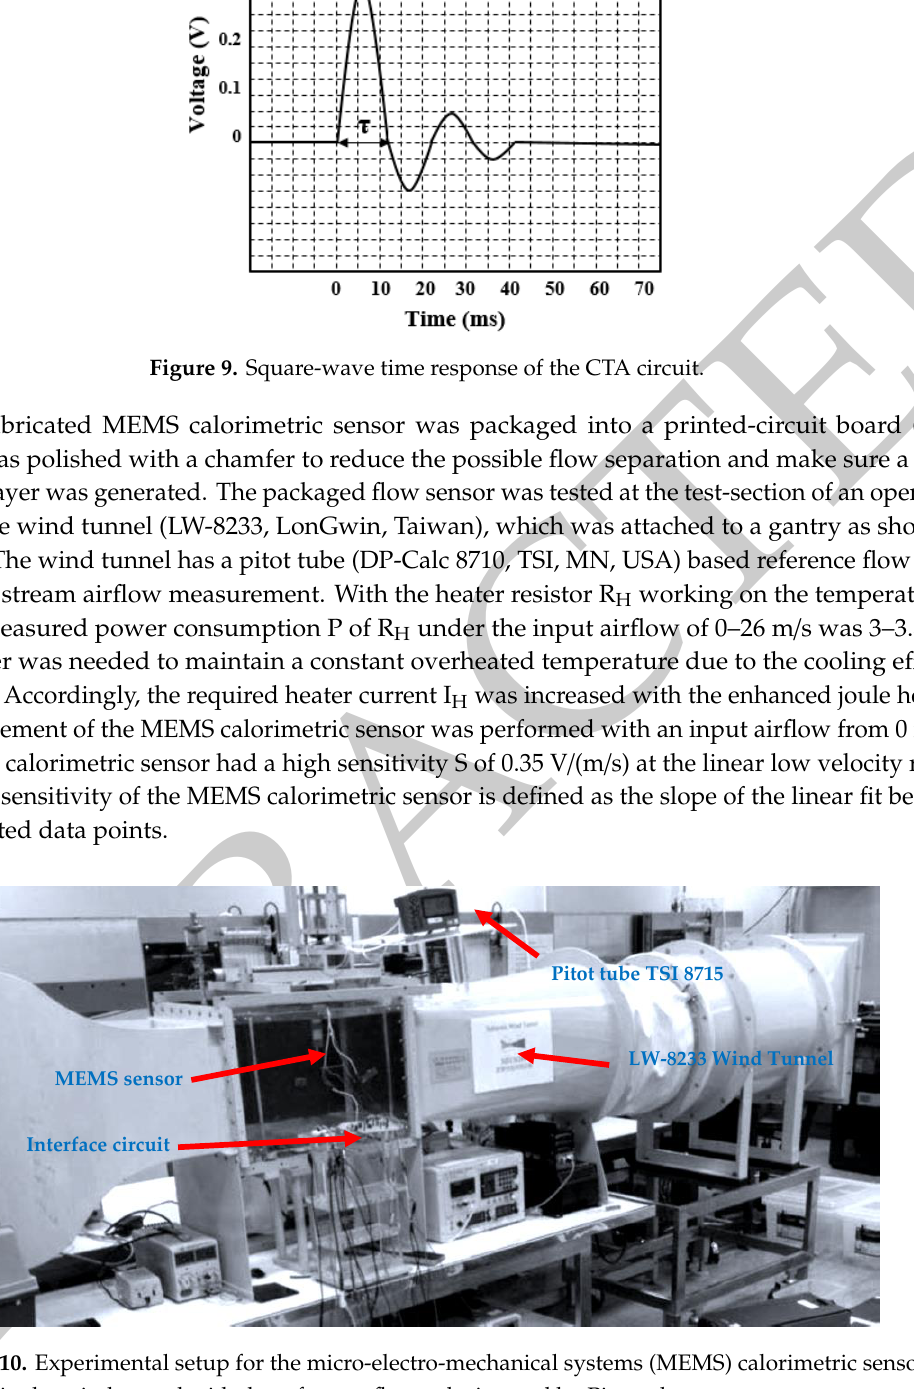
Figure 8. Transient response of the CTA circuit with V TR = 1.5 V.